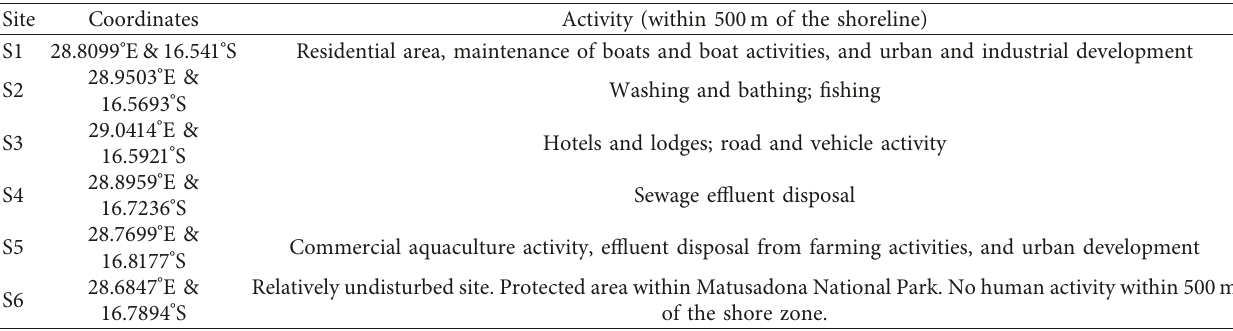
Figure 1: Map of Sanyati basin, Lake Kariba, showing the six (S1-S6) sampling sites between January and March 2018 (Inset: map of Zimbabwe). Table 1: Location and description of the study